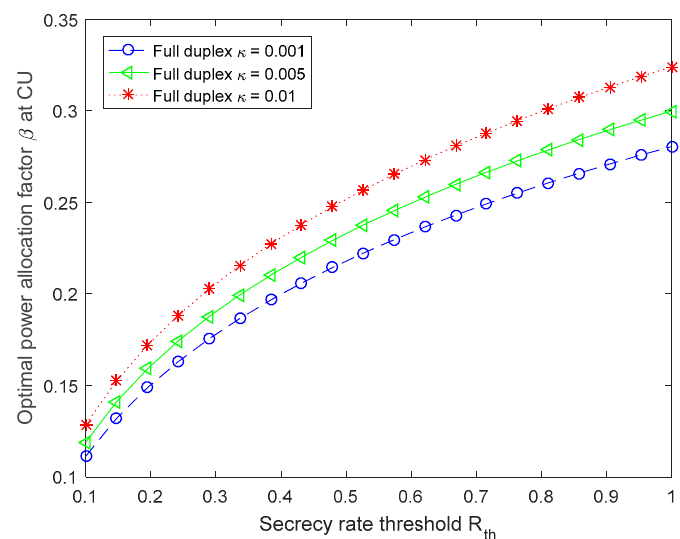
Figure 2. The optimal power allocation factor at cellular user (CU) under various secrecy rate thresholds.